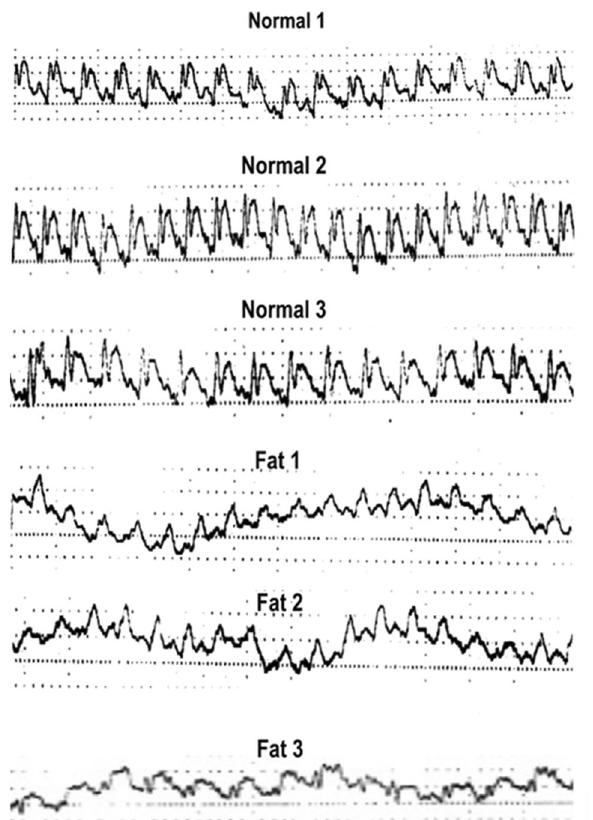
Figure 4. The ECG results of Syrian